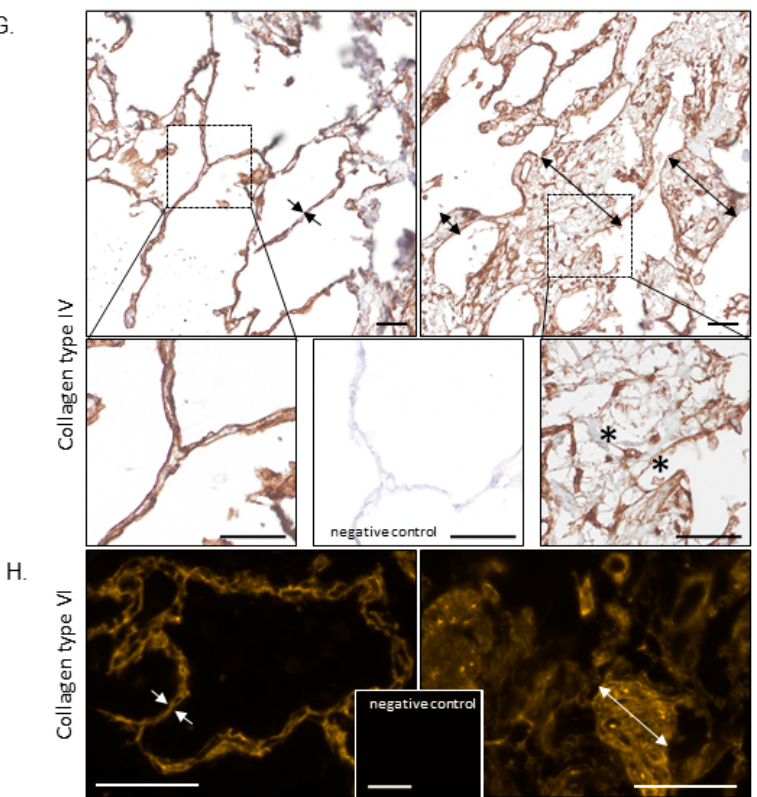
Figure 2. Proteomic and histological characterization of healthy and IPF derived tissue scaffolds. ( A ) Number of identified proteins in decellularized scaffolds derived from healthy individuals (biological replicates n = 2, technical replicates n = 3) and IPF patients ( n = 2, n = 3). Protein groups assigned to matrisome affiliation. ( B ) Matrisome grouped summed raw intensities for proteins in healthy and IPF derived scaffolds, left panel. Matrisome grouped summed intensities after density adjustment in healthy and IPF scaffolds, right panel. Mean values for groups presented. ( C ) Statistics for summed matrisome groups. Student’s t -test with Benjamini-Hochberg corrected p -values * p < 0.05. ( D ) Unsupervised hierarchical clustering of significantly different matrisome proteins characteristic for the scaffold types using Z-scored values. Basement membrane proteins marked with *. ( E ) Spearman correlation between scaffold groups. ( F ) Histological verification and spatial tissue distribution of selected matrisome (or basement membrane) proteins. Hematoxylin/Eosin staining showing distinct morphological differences between thin, alveolar septa (healthy scaffold) compared to thickened, fibrotic remodeled septa (IPF scaffold). ( G ) This is accentuated (arrows) by staining for collagen type IV (brown), indicating clear basement membrane staining lining the alveolar septa in the healthy scaffold compared to disorganized fragments in the IPF scaffold, with large areas devoid of collagen type IV signal or reduced intensity (*). ( H ) Inversely, collagen type VI showed accumulation in these fibrotic structures in the IPF scaffold. Scale bar 50 µm.